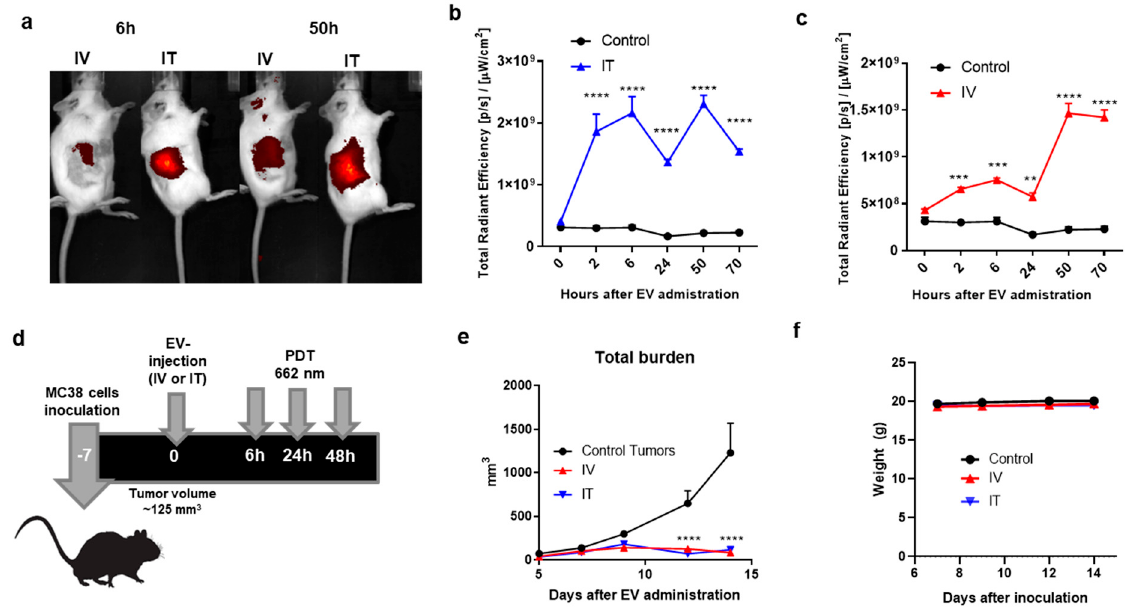
Figure 4. Biodistribution and effect of EV-ZnPc after PDT in vivo. Mice were inoculated subcutaneously with 0.5 × 10 6 MC38 cells in 200 μ L PBS in the right flank. At day 7, when the tumors were an average size of ~125 mm 3 , EV-ZnPc were injected intravenously (IV) or intratumorally (IT). Non-invasive fluorescence imaging was performed at 2, 6, 24, 50, and 70 h after injection using the IVIS fluorescence spectrometer. ( a ) Representative NIR700 fluorescence imaging in the tumor area of mice at 6 and 50 h after injection. Fluorescence intensity of the NIR800 signal after ( b ) IT or ( c ) IV injection. ( d ) Schematic representation of protocol used for PDT assay: mice were inoculated with MC38 cells in the flank and injected with EV-ZnPc as mentioned above. PDT was performed by illumination of the tumor on the right flank with 662 nm light at 116 mW/cm 2 for 116 J/cm 2 over 1000 s. ( e ) Tumor growth curves and ( f ) weight of the animals were evaluated over 14 days after inoculation. Data are means ± SEM from n = 4 mice per condition. **** p < 0.0001; *** p < 0.001; ** p <